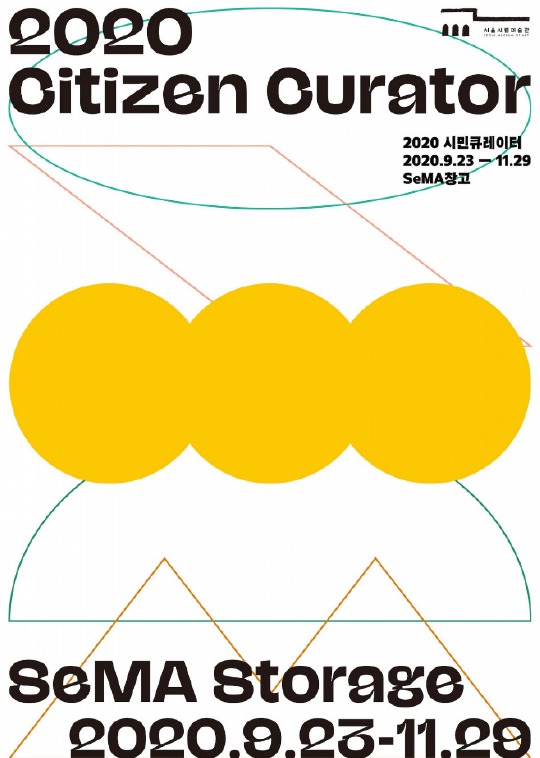
Figure 3. Poster of the 2020 Citizen Curator of SeMA Storage. (Copyright ⓒ 2020 SeMA All rights reserved. made by Waterain); “Official Website of SeMa”)